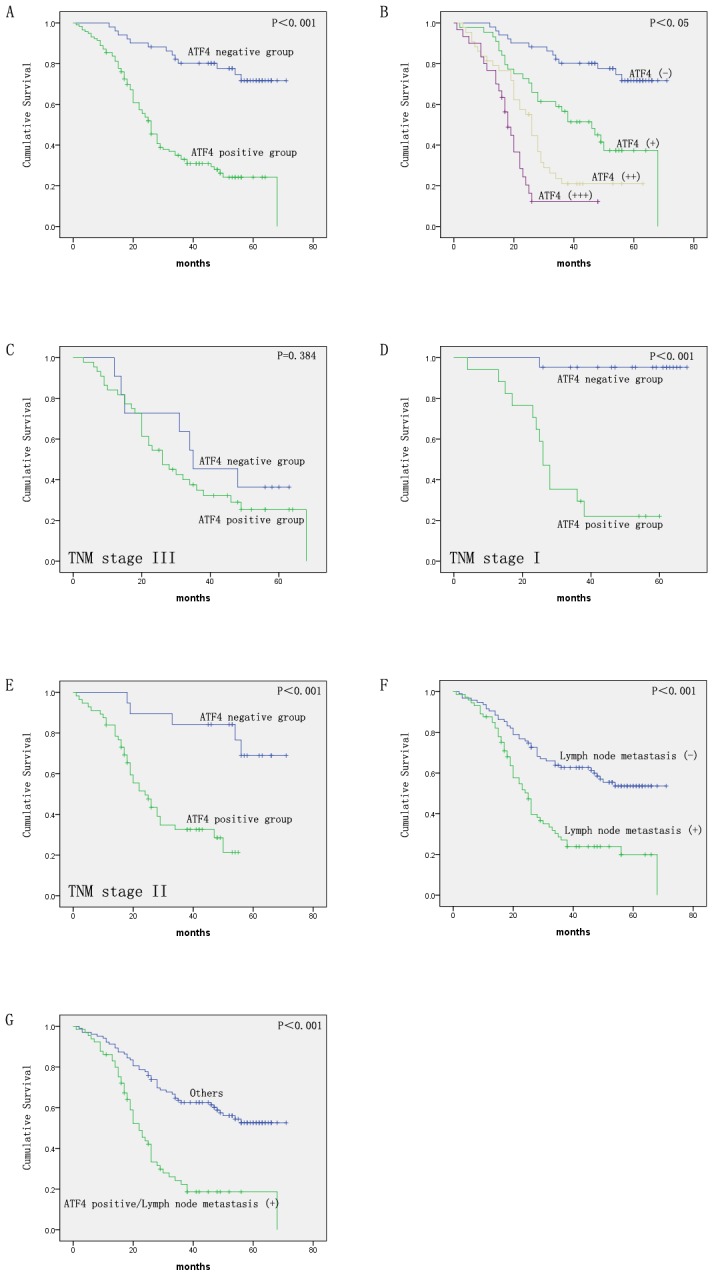
Kaplan-Meier survival curves of ESCC.Cases were stratified based on overall ATF4 expression levels (A) and ATF4 staining intensities (B). In the patient subgroups, cases were stratified based on overall ATF4 expression levels for the stage III (C), the stage I (D), and stage II (E) groups. (F) Cases were stratified based on lymph node metastasis status. (G) Cases stratified based on ATF4 expression (+) and lymph node metastasis (+).